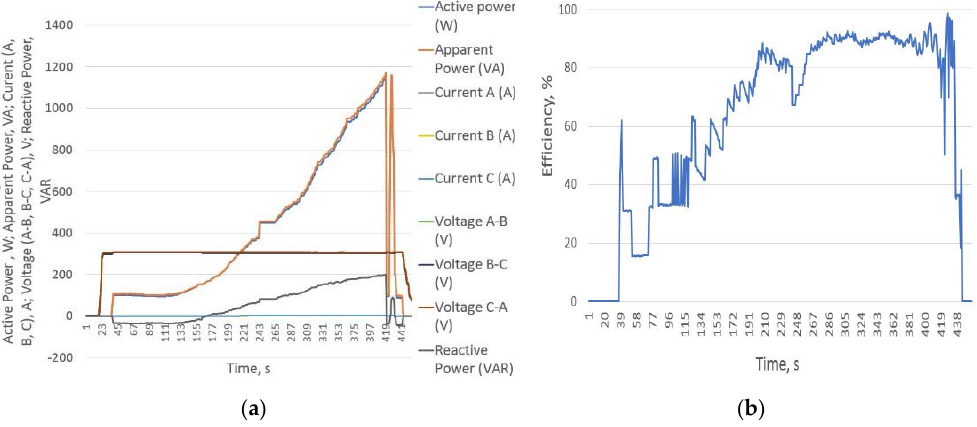
Figure 6. The results of PMSM efficiency determination experiment with nominal 302 ‐ V voltage applied during the experiment. ( a ) Electrical PMSM input parameters; ( b ) efficiency curve.